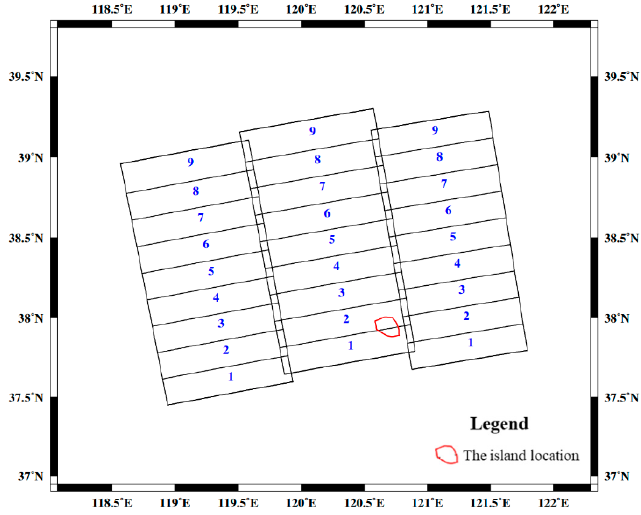
Figure 3. Data processing range (the number represents each burst sequence